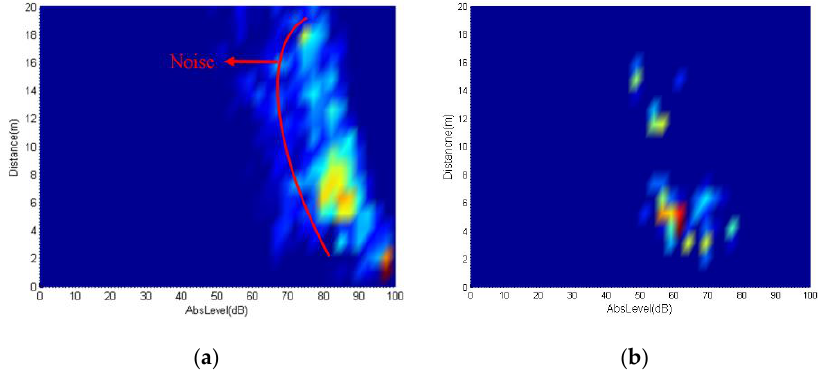
Figure 3. Statistical results of the radar signal: ( a ) real object and ( b ) non-real object.